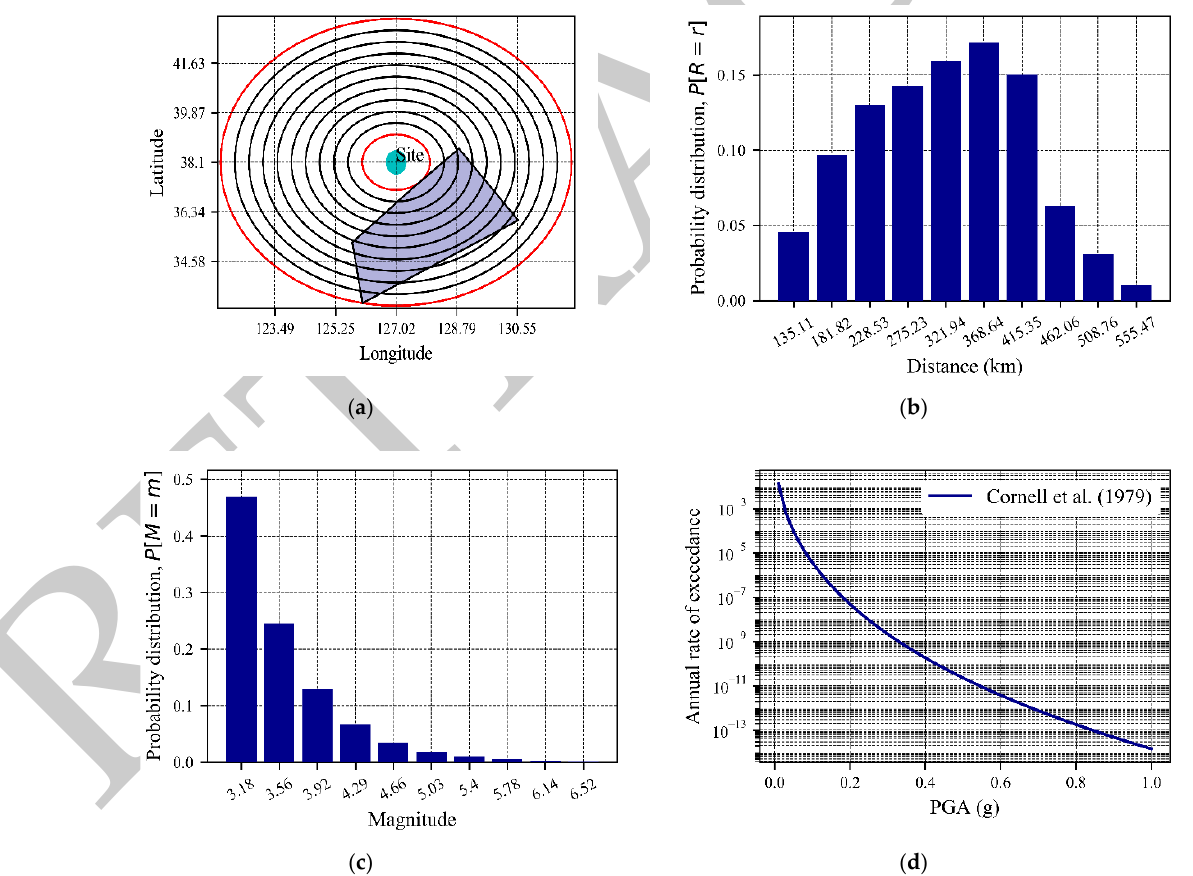
Figure 17. ( a ) Segmental view of area source, ( b ) Probability density function of distance, ( c ) Illustration of probability density function for magnitude for a source with a truncated Gutenberg–Richter distribution, ( d ) Probabilistic seismic hazard curve, respectively for RS1.